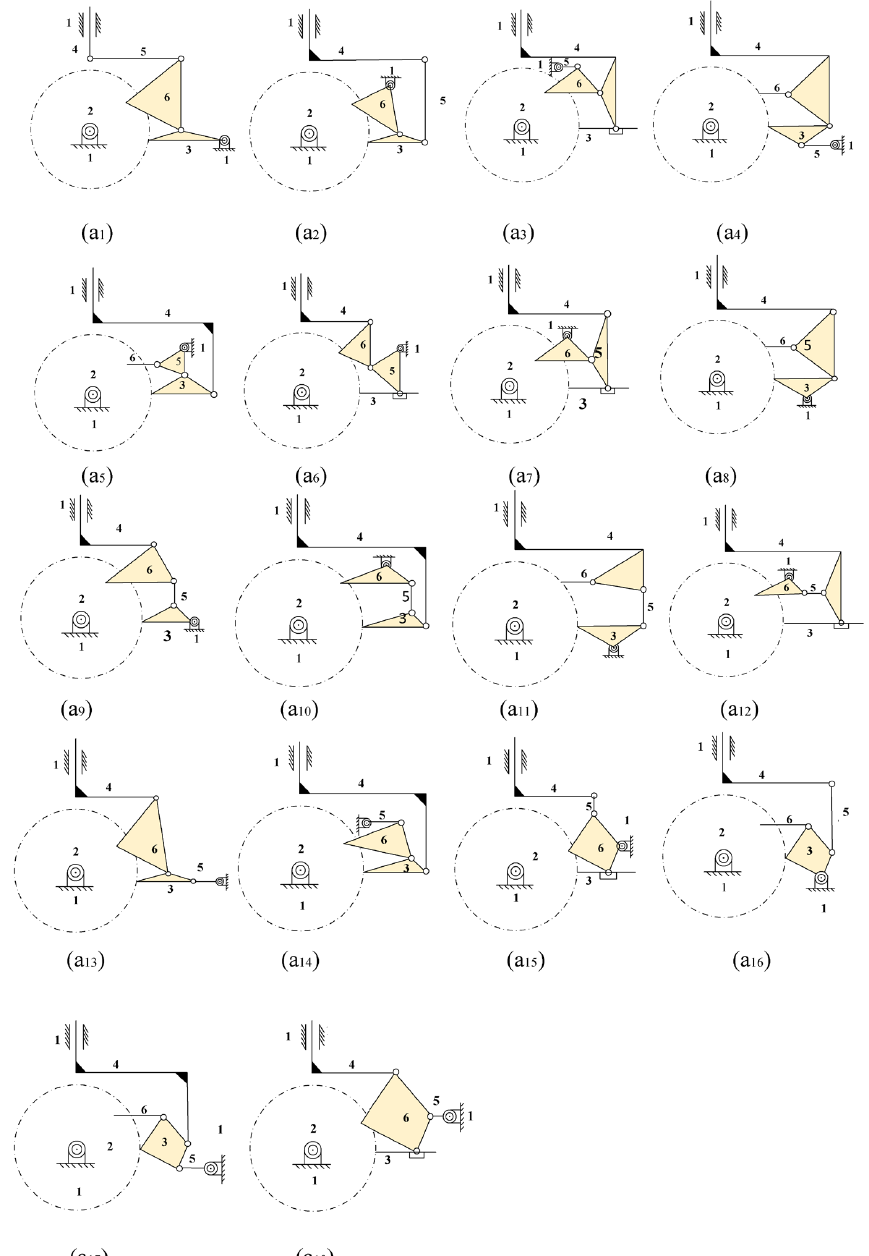
Figure 17. Atlas of feasible designs – model